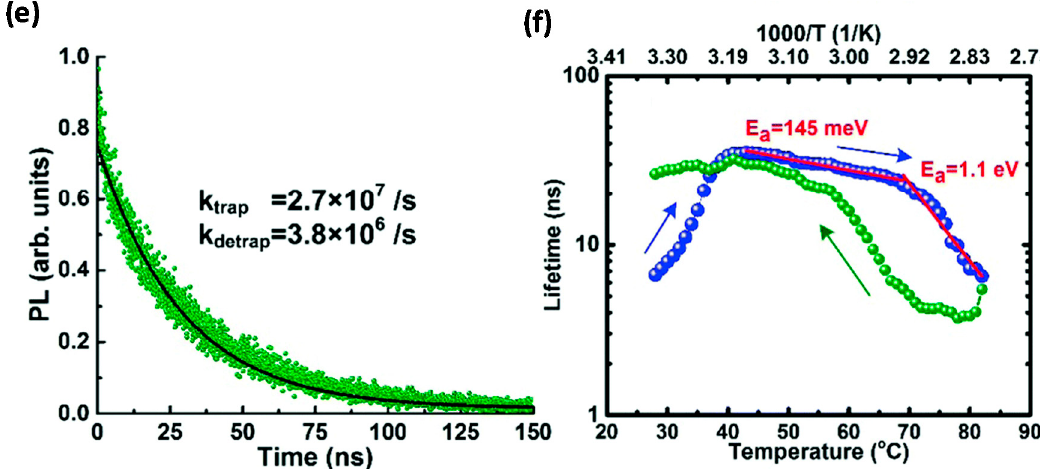
Figure 6. Temperature dependent ( a ) absorbance and ( b ) photoluminescence spectra of MAPbI 3 when the temperature is increased from 28 °C to 85 °C. Reprinted with permission from [47]. ( c ) photoluminescence (PL) intensity plotted as a function of temperature showing three transitional PL peaks during the heating process. ( d ) PL measurements as a function of temperature during the heating and cooling processes (room temperature to 52 °C). ( e ) Best-fit of lifetime decay using trapping and detrapping model. ( f ) Evolution of the lifetime of MAPbI 3 − x Cl x during heating and cooling processes. The trap depths of 145 meV for temperatures in the range 40–70 °C and 1.1 eV above 70 °C were obtained from a quantitative analysis of the Arrhenius plots. Reprinted with permission from [48] .